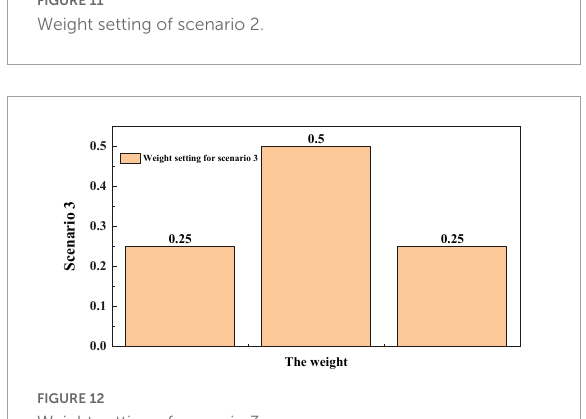
FIGURE11 Weight setting of scenario 2.